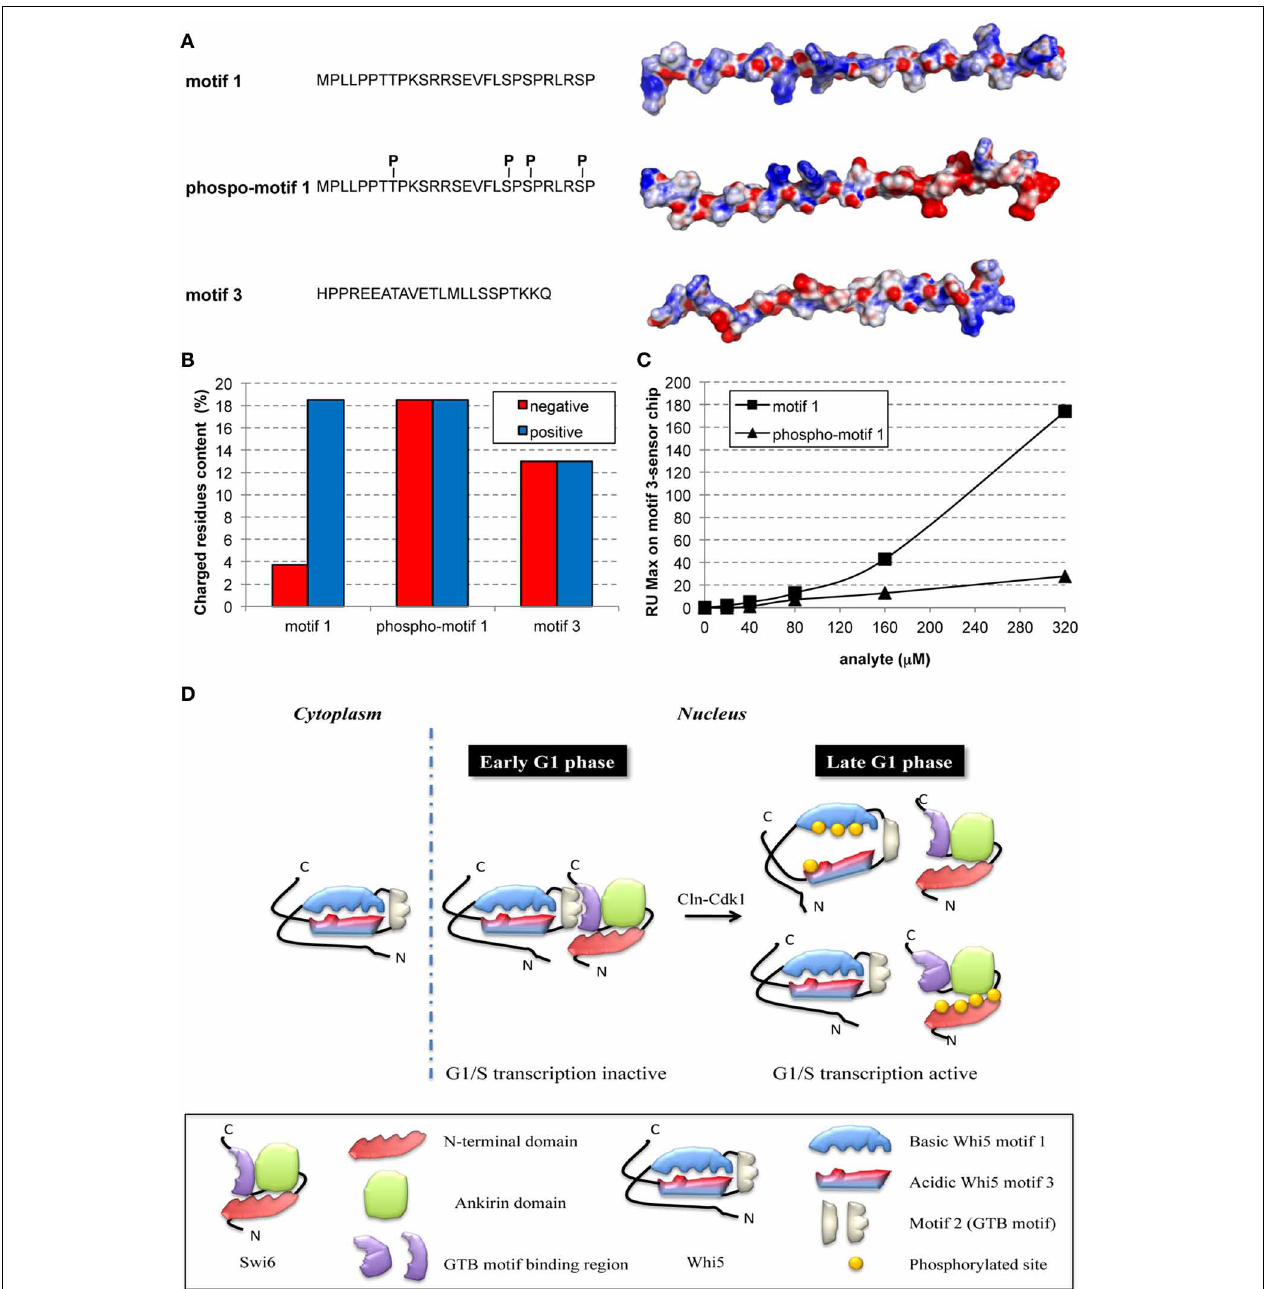
FIGURE 3 | Phosphorylation hampers in-vitro interaction between peptides representing motifs 1 and 3 of Whi5 Sc . (A) Amino acid sequence and electrostatic potential surface of Whi5 Sc -derived peptides representing conserved motifs and assayed in SPR experiments: motif 1 (136–162), phospho-motif 1 (136–162), and motif 3 (245–267). Phospho-motif 1 peptide differs from motif 1 only for the presence of specific phosphorylated residues of tyrosine and serine indicated as pT and pS. The electrostatic potential maps are projected on the solvent accessible surface of the peptides. The molecular surface of the